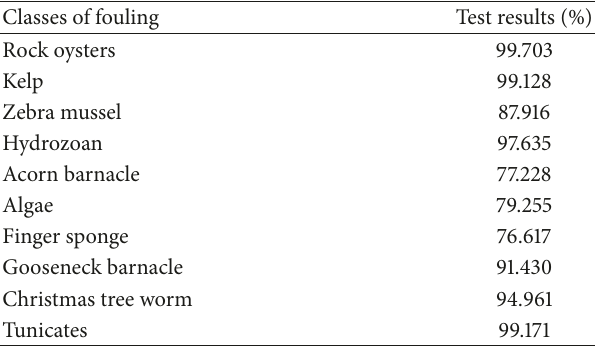
Table 5: Final testing results of fouling